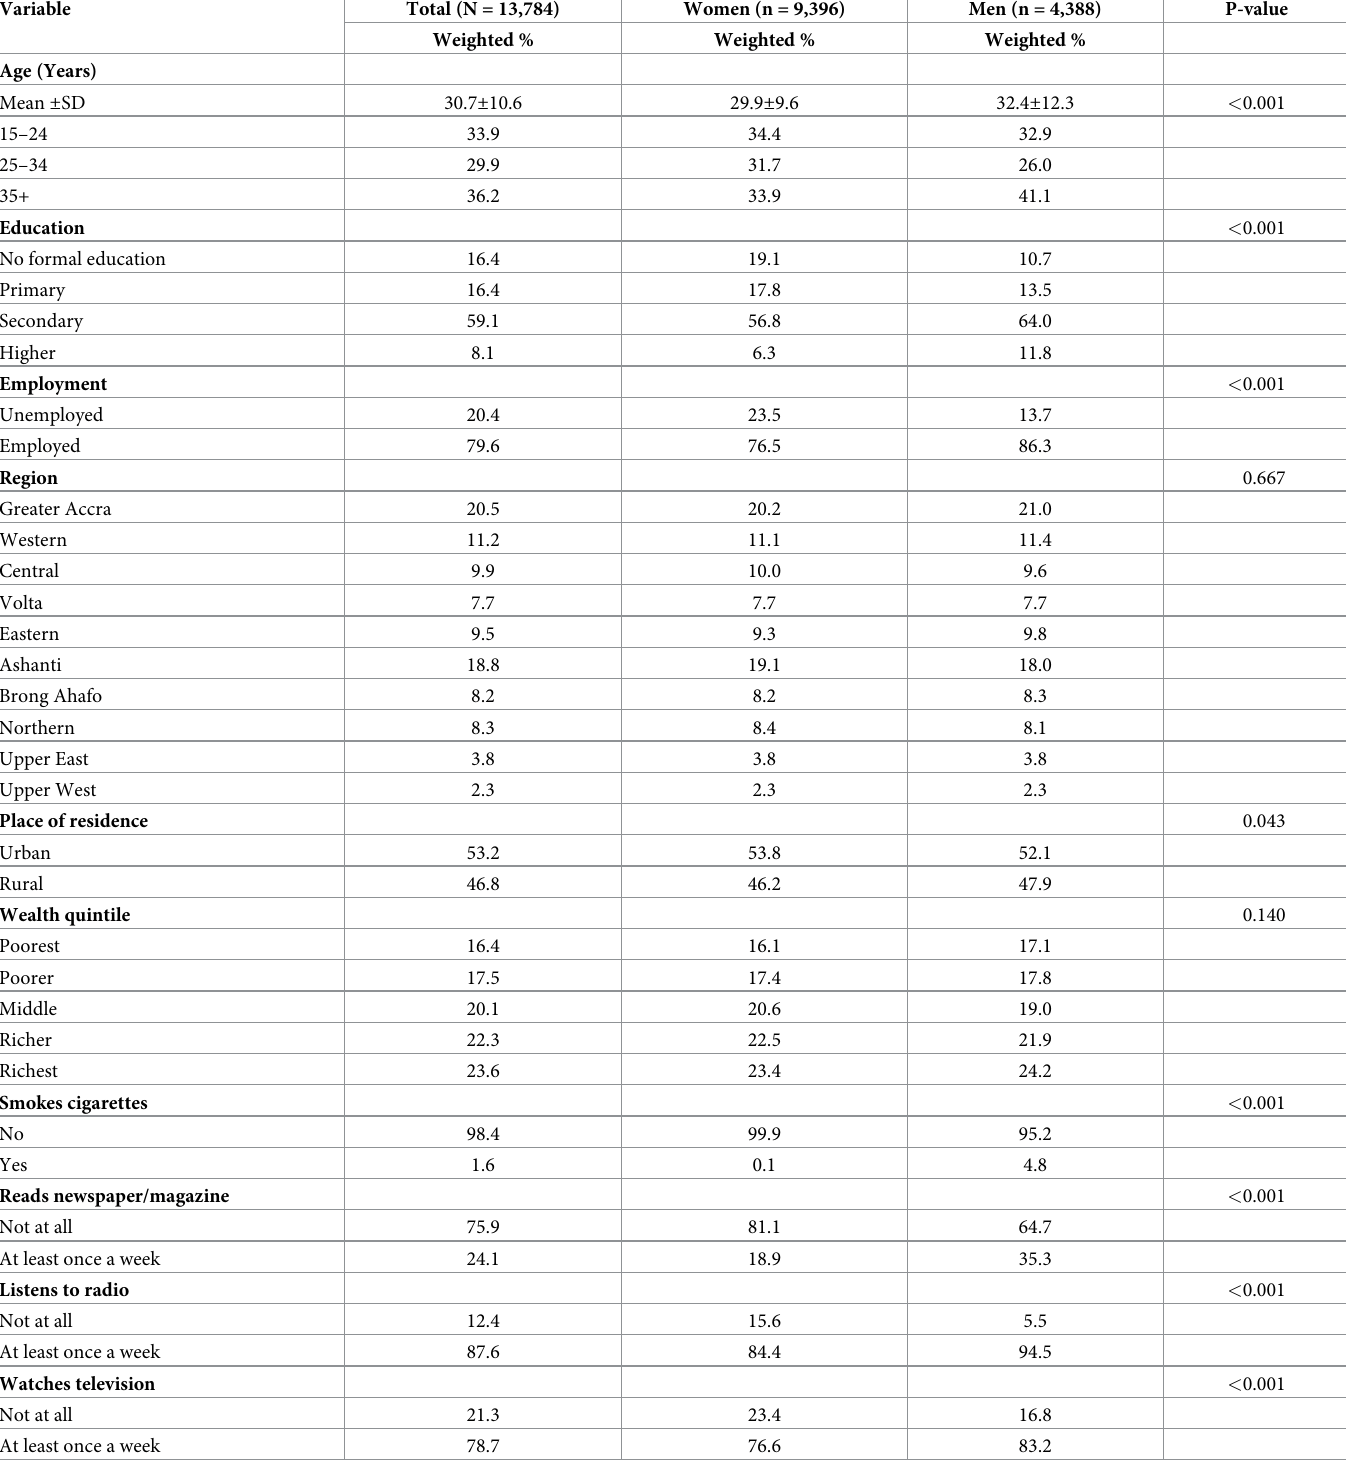
Table 1. Background information of respondents in this study (N =